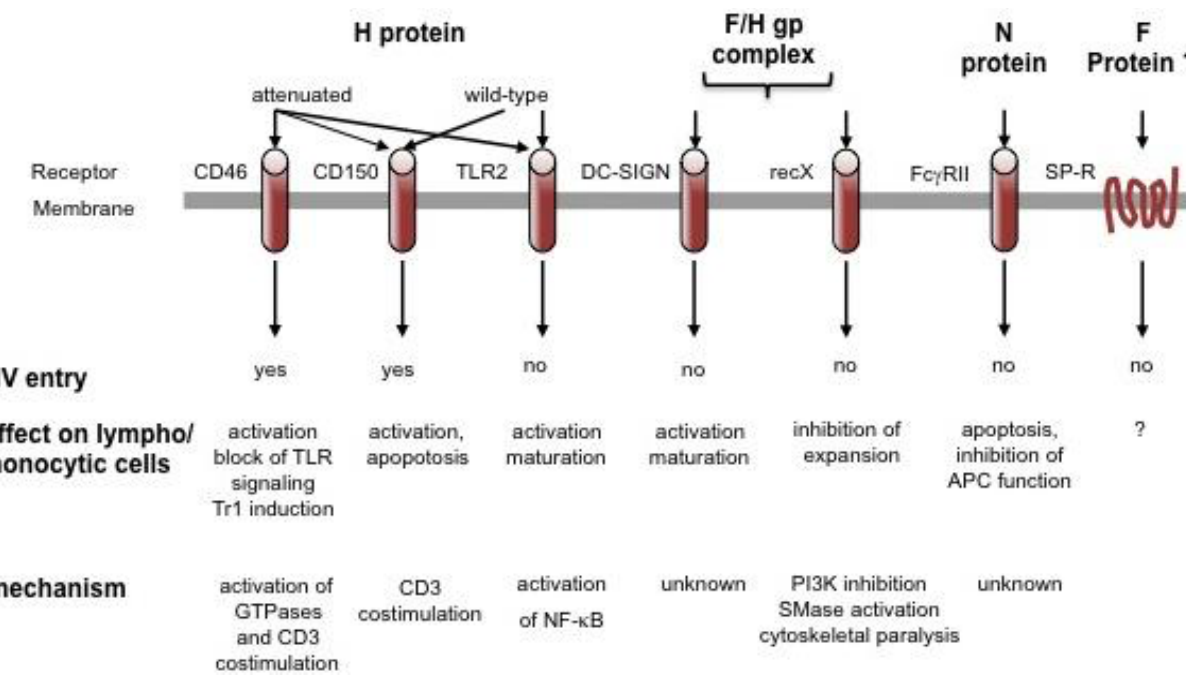
Figure 1. Cellular surface molecules interacting with measles virus (MV). Surface receptors may interact with different MV protein or protein complexes, yet only CD46 and CD150 support MV entry. This may be enhanced by substance P receptor interaction, and, on dendritic cells (DCs), by DC-SIGN which, as TLR2, promotes APC activation on MV binding by relaying signals. Signaling by CD46 and CD150, which can act as CD3 co-stimulators, has mainly been investigated on antibody ligation and has not yet been directly addressed to occur after MV interaction. Signaling via recX and Fc  R by MV has been directly linked to inhibition of lympho/monocytic expansion and/or